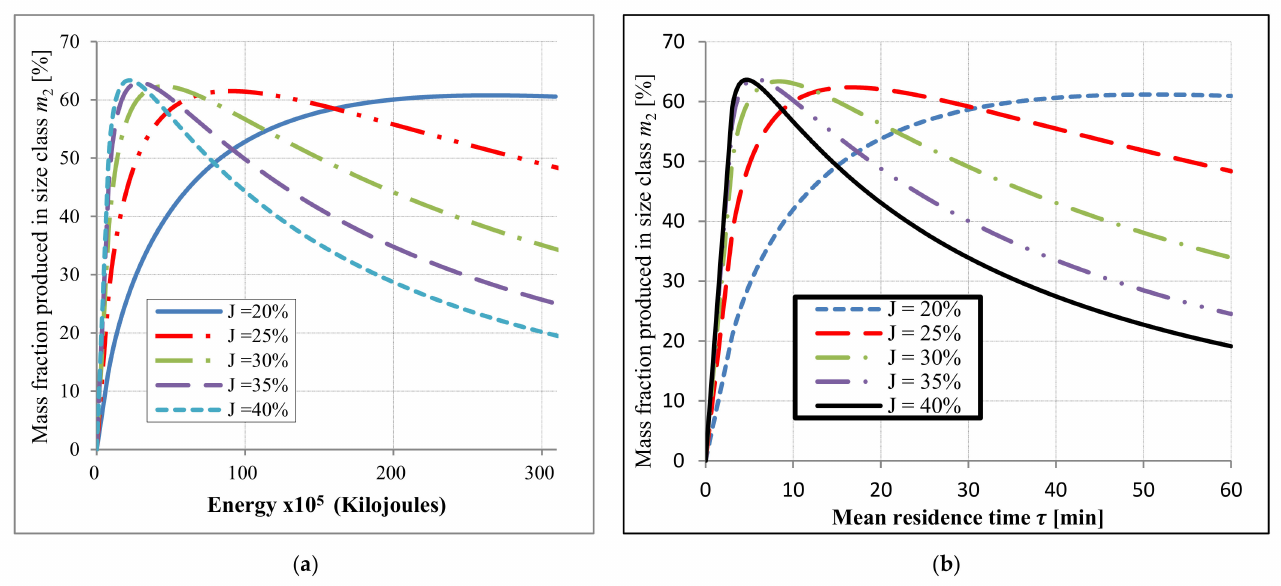
Figure 7. Effects of media filling level on mill throughput on ( a ) the extent of energy used and ( b ) the residence time